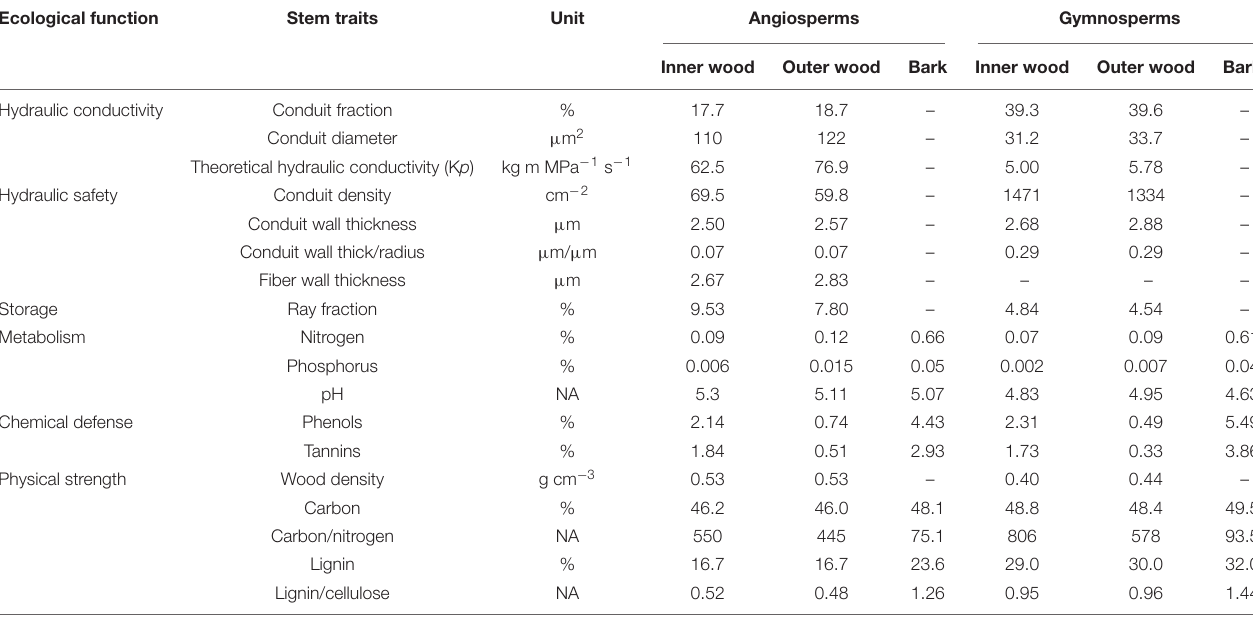
FIGURE 2 | The percentage of trait variation explained by major taxa (angiosperms vs. gymnosperms; pink), species within major taxa (blue), and compartments (inner wood, outer wood and bark, orange), and the unexplained variation (green). The traits are grouped into six stem functions: hydraulic conductivity, hydraulic safety, storage, metabolism, chemical defense, and physical strength. TABLE 3 | Stem trait variation in % among compartments of angiosperm and